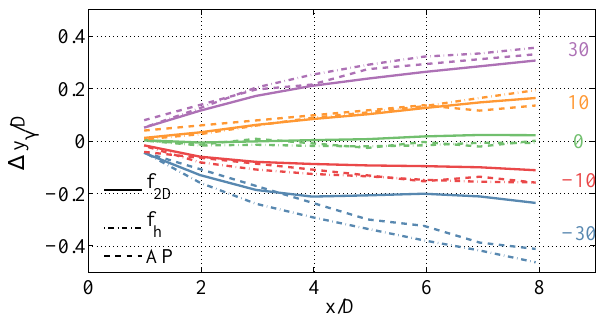
Figure 6. Wake deflection trajectories in the NBL from different fits to the data. Numbers on the right denote the turbine yaw angle for the different